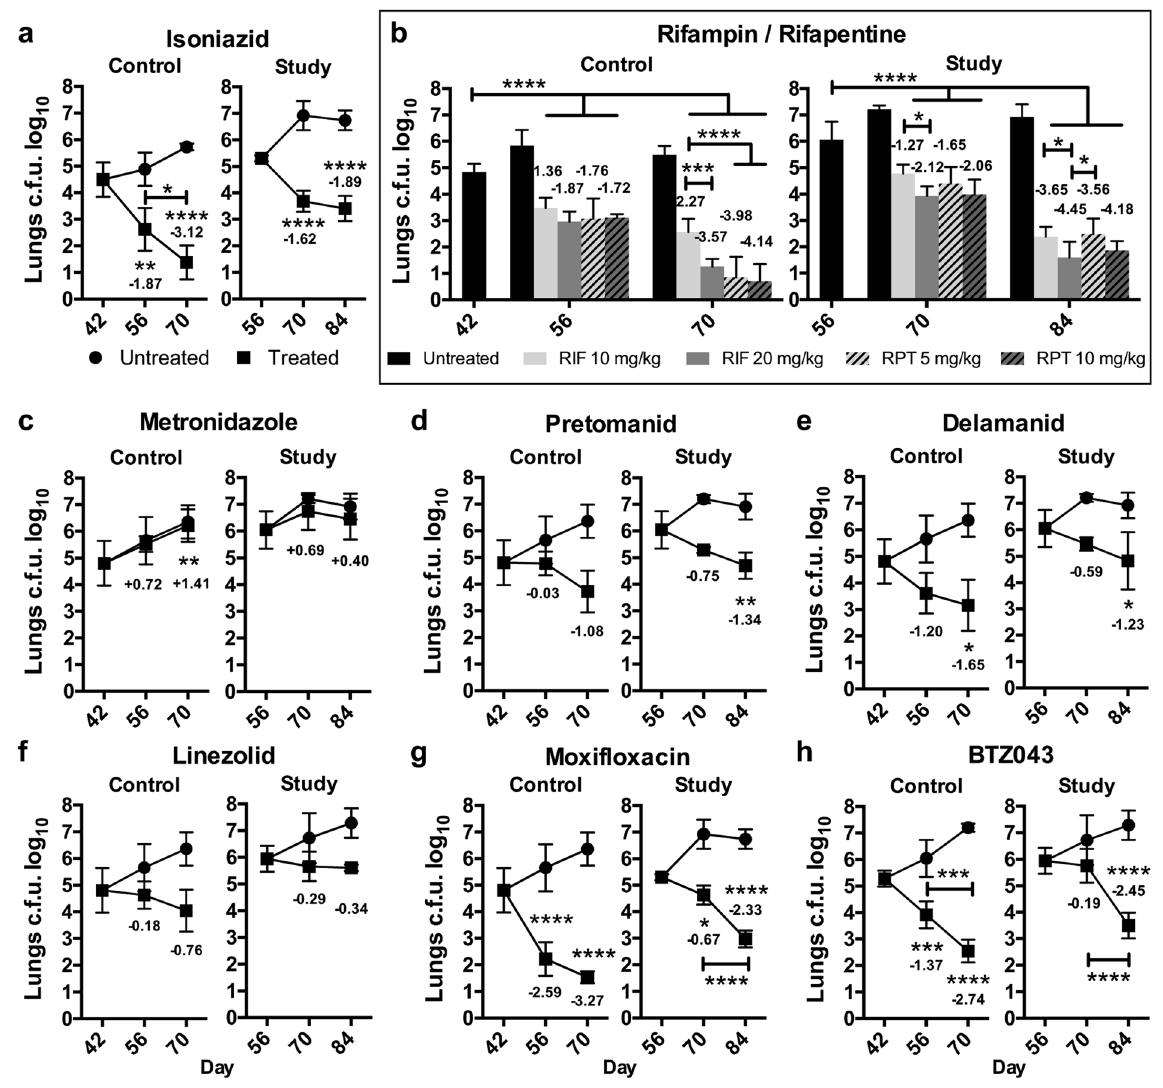
Figure 3. Impact of monotherapy on pulmonary bacterial burden in Nos2 − / − mice with TB. Monotherapy for 4 weeks was initiated at day 42 (control group) or after onset of central necrosis and hypoxia in lung lesions at day 56 (study group) as described in Fig. 1a. Drugs were administered by oral gavage on 6 days per week. Bacterial burdens in lungs were assessed by plating organ homogenates on agar. One representative dataset out of 2 independent experiments is shown. Data were analysed using two-way ANOVA with multicomparison and Tukey’s post-test. Shown are means ± s.e.m. and the log10 reduction of mean c.f.u. counts as compared to animals prior to chemotherapy (summarized in Supplementary Table S1), n = 5, * p < 0.05, ** p <